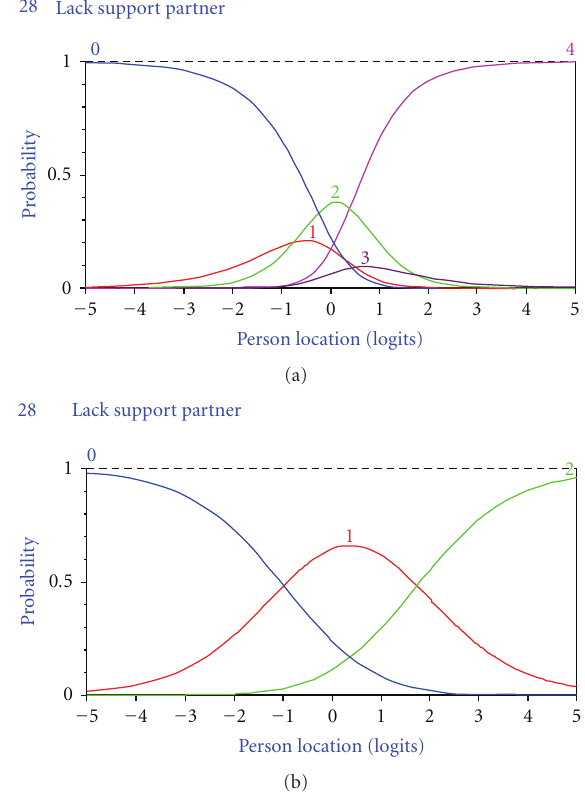
Figure 1: Category probability curves depicting the probability (y- axis) of observing responses in each category (0 = never; 1 = seldom; 2 = sometimes; 3 = often; 4 = always) relative to the location on the measured construct (x-axis; positive values = more problems) for item 28 before (a) and after (b) rescoring. This item was associated with multiple disordering (thresholds 0-to-1/1-to-2 and thresholds 2-to-3/3-to-4) and needed reduction from five to three response categories (combination of responses to categories 1, 2, and 3 into a single